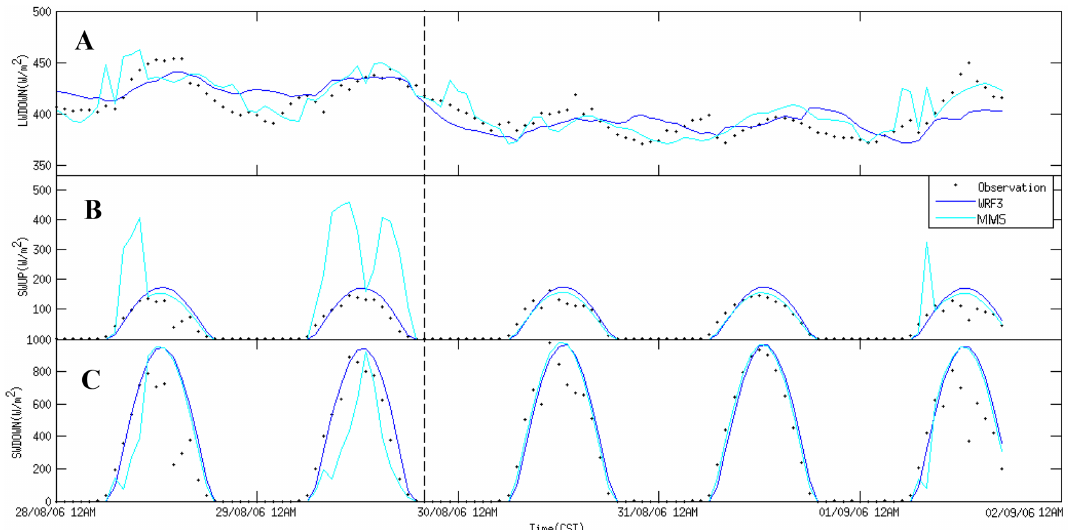
Figure 4. Time series for incoming longwave (a) , outgoing shortwave (b) , and incoming shortwave (c) radiation for observations (dots) and for the WRF (blue) and MM5 with EDAS (green)